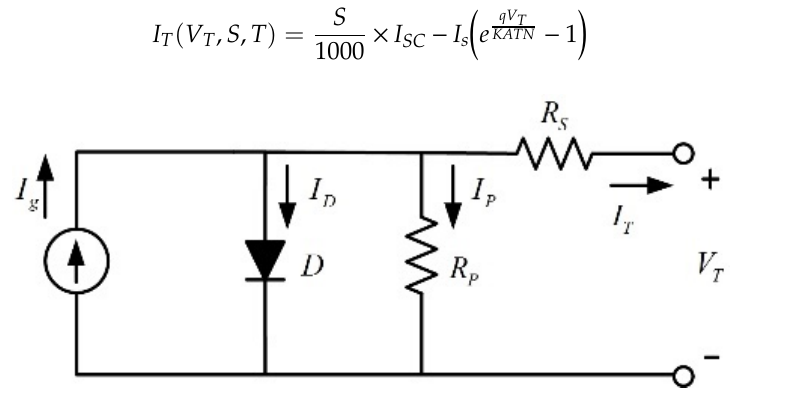
Figure 1. Equivalent circuit of solar cell.